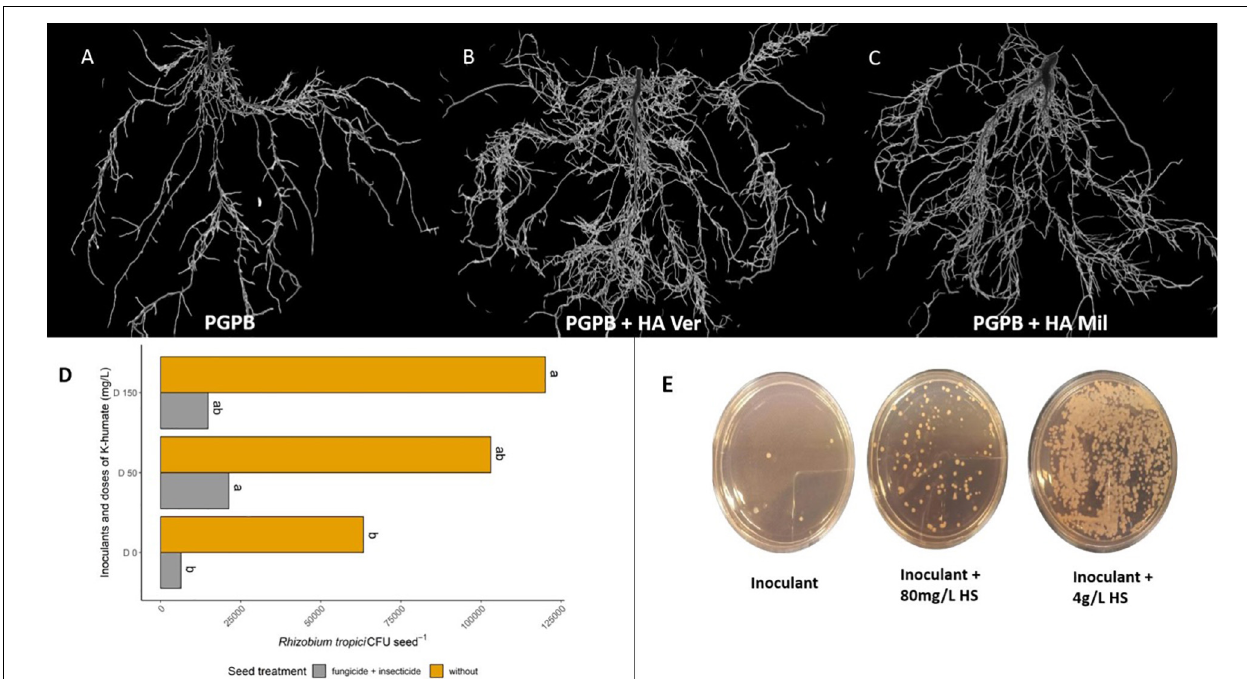
FIGURE 1 | Effects related to the combined use of plant growth-promoting bacteria (PGPB) and humic substances (HSs). (A–C) Show the positive impact on the branching and biomass of soybean roots inoculated with Bradyrhizobium (A) and treated with a combination of humic acid from vermicompost (B) and millicompost (C) in the soil. (D) Shows the increased survival of Bradyrhizobium (D0) in soybean seeds in the presence of 50 (D50) and 150 (D150) mgL − 1 K-humate in both “raw” seeds (yellow bars) and seeds treated with fungicide and insecticide (gray bars). The values are expressed in colony-forming units (CFU) of Bradyrhizobium per gram of seed. (E) Increased growth of Rhizobium tropici (inoculant) with the application of K-humate (unpublished data). Figure created using BioRender (https://biorender.com/).